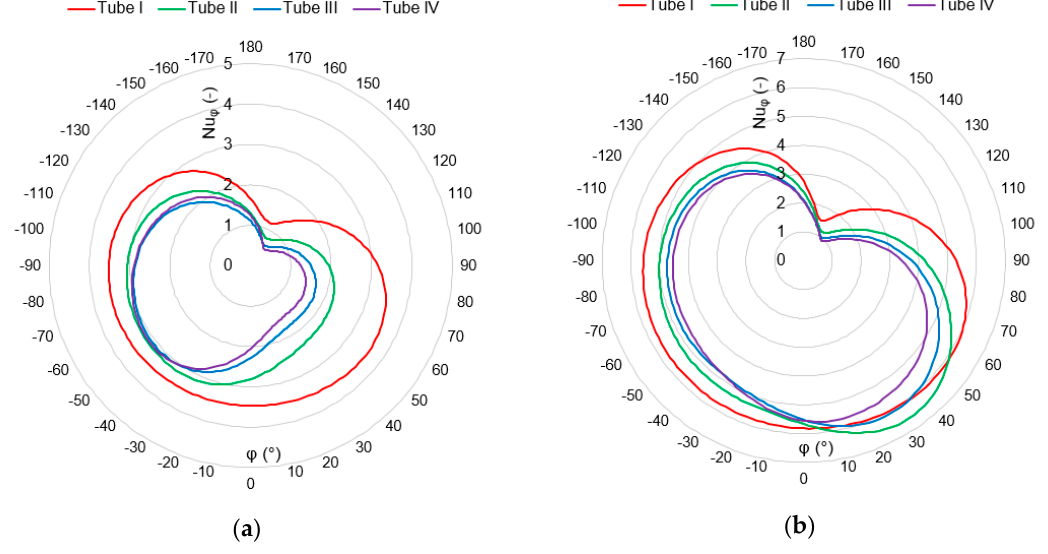
Figure 7. The course of the local Nusselt numbers Nu φ for the individual tubes in tube array 4 × 2: ( a ) Ra = 10 3 ; ( b ) Ra = 10 4 .